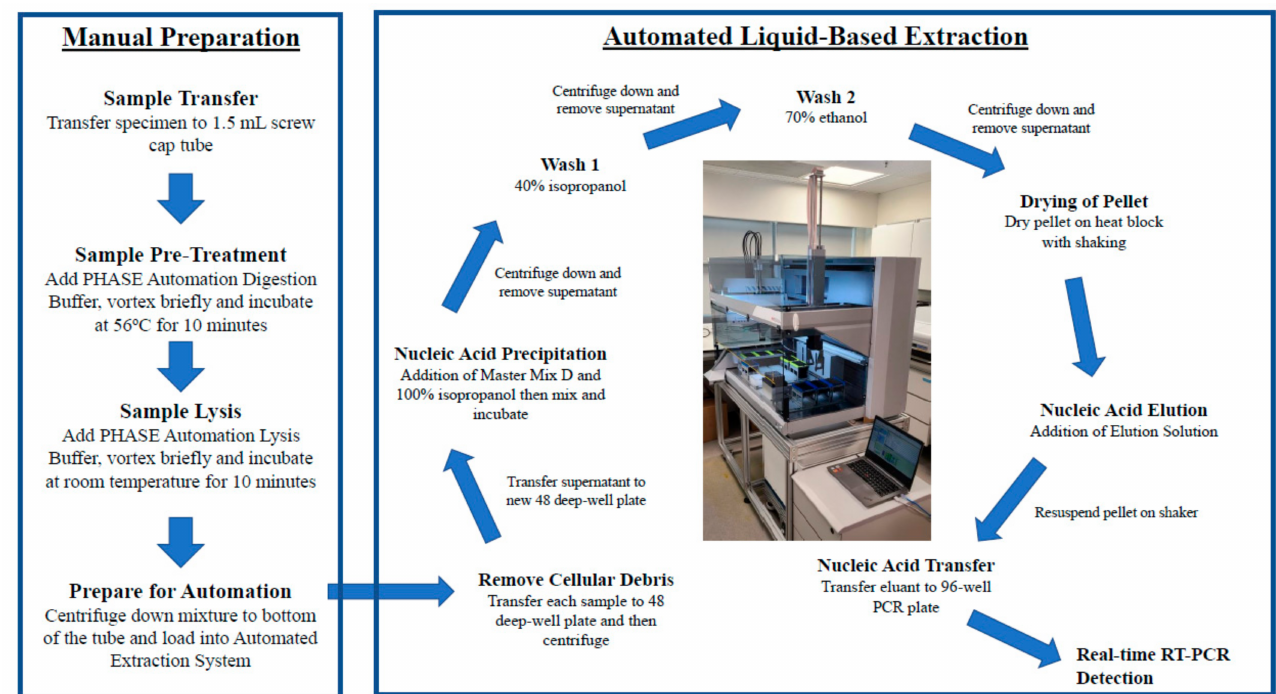
Figure 1. Workflow of the automated high-throughput liquid-based RNA